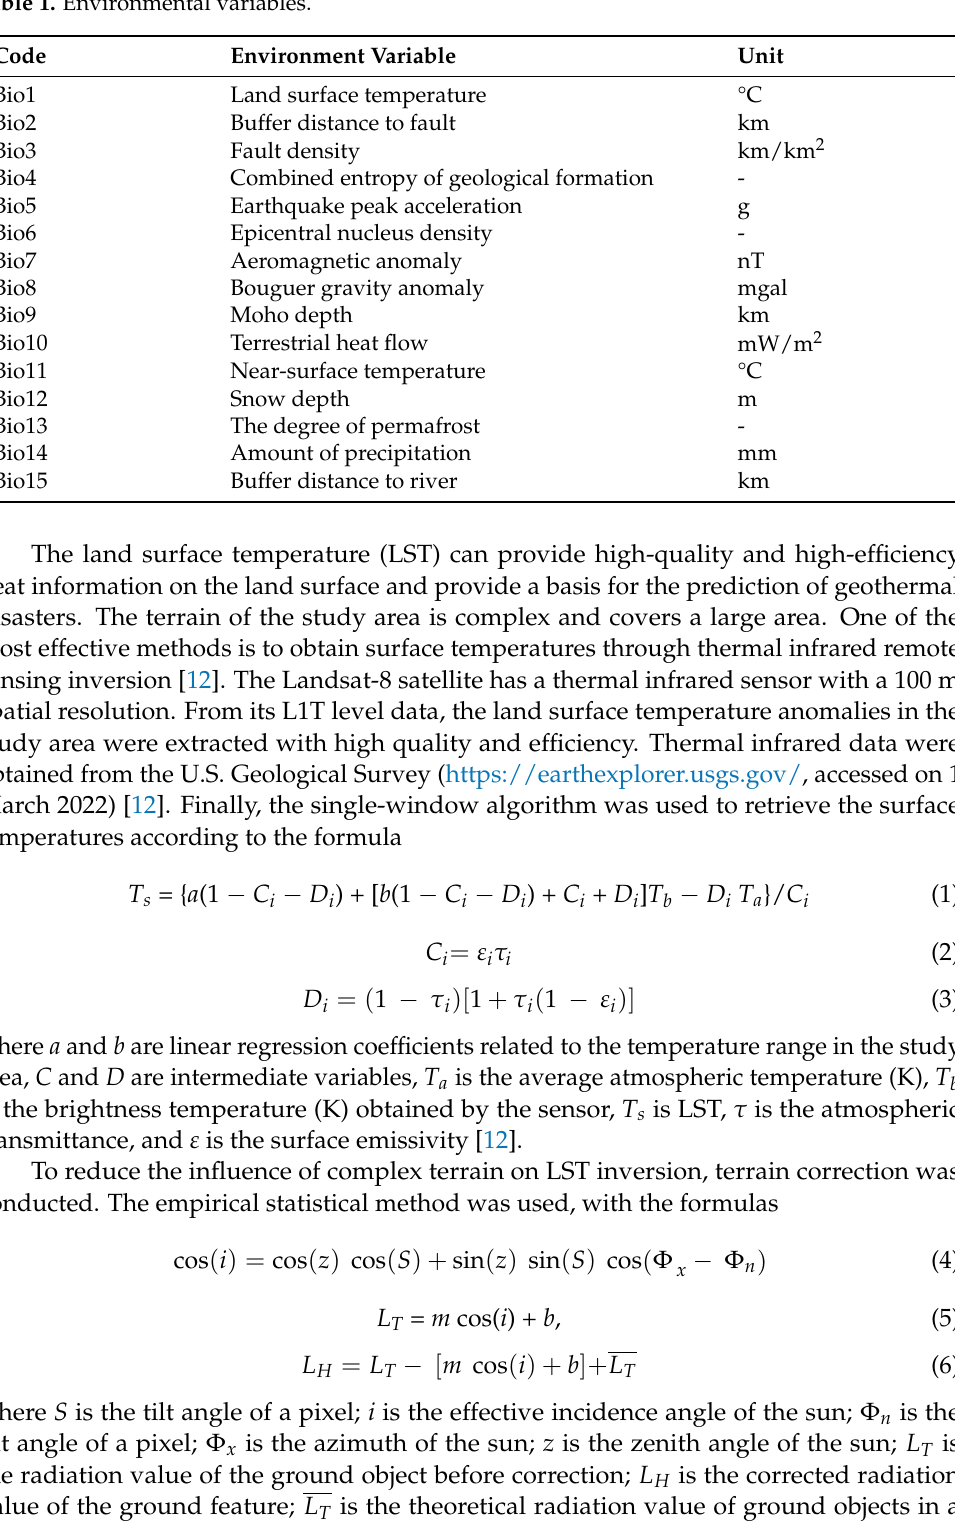
Table 1. Environmental